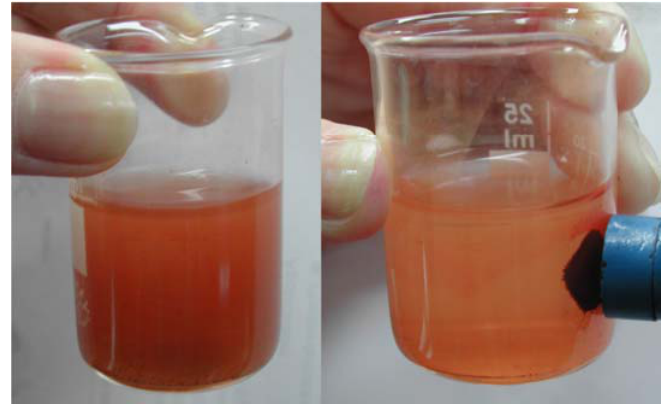
O nanoparticles dispersed in water. 2 3